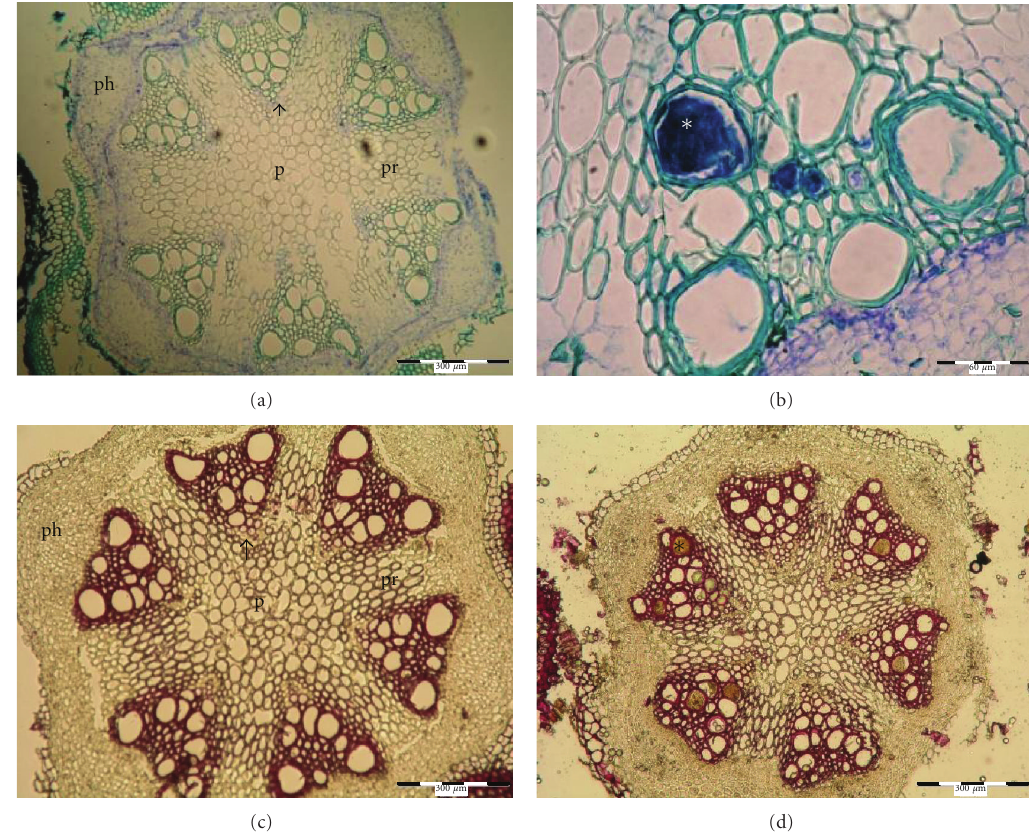
Figure 6: Histochemical identification of lignins in xylem occlusions in stems of Clematis “Solidarno´s´c” by using Azur B and phloroglucinol- HCl methods. (a) and (b) Identification of lignins in xylem of control stems; (c) and (d) Identification of lignins in xylem of stems kept in distilled water; p: pith, pr: pith rays, ph: phloem, arrow: xylem vessel, c: cortex with lamellar collenchyma, ∗ : blocked xylem lumen. their serious antiseptic properties. The tyloses observed here also included proteins probably transported as an extracel- primary